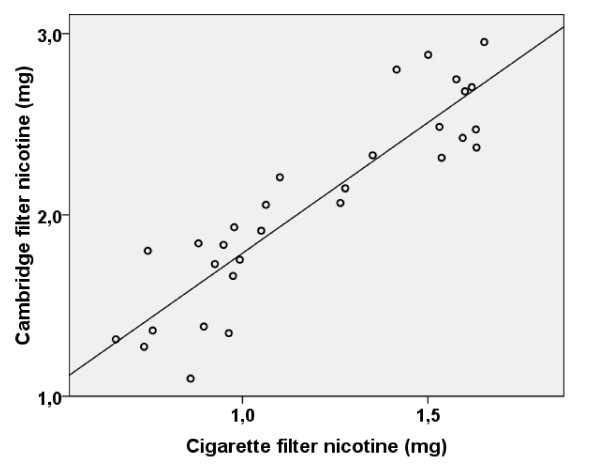
Correlation between cigarette and Cambridge filter nicotine (Pearson's correlation coefficient of 0.90).